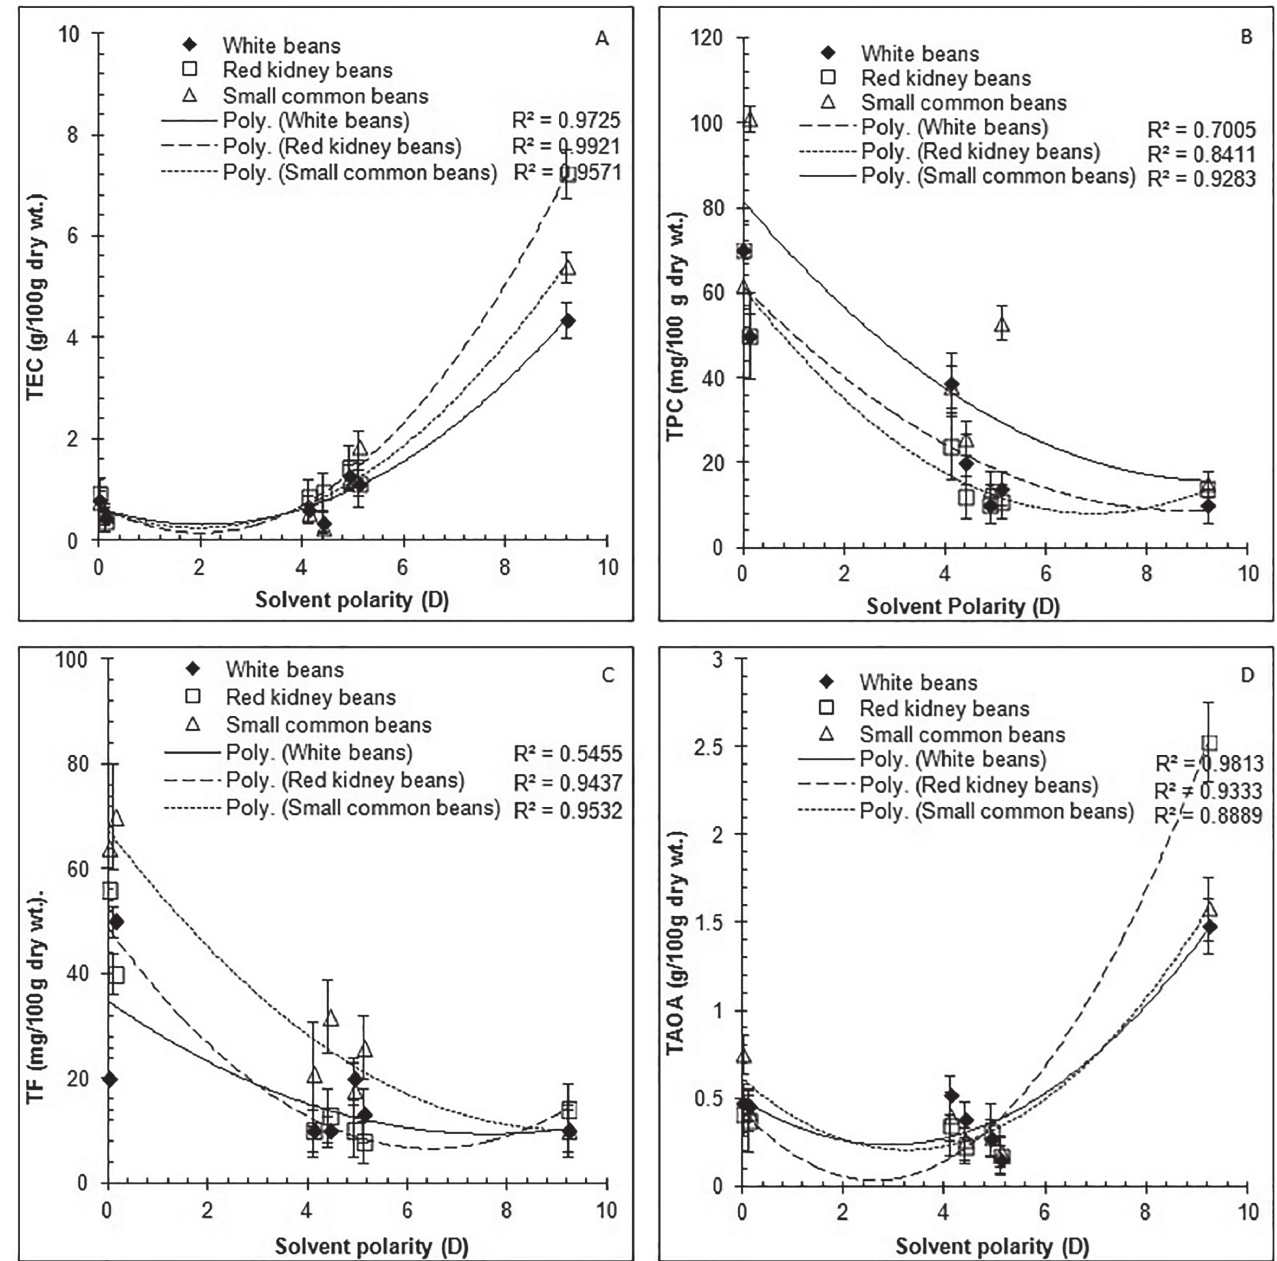
FIGURE 2 - The solvent polarity dependent response of A: total extractable components (TEC), B: total phenolic content (TPC), C: total flavonoid content (TFC) and D: Total antioxidant activity (TAOA) of three varieties of bean